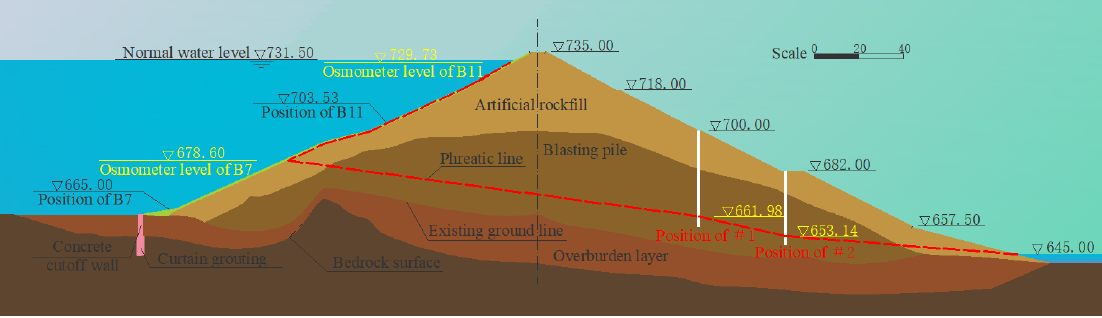
Figure 12. The phreatic line of the blast-fill dam.